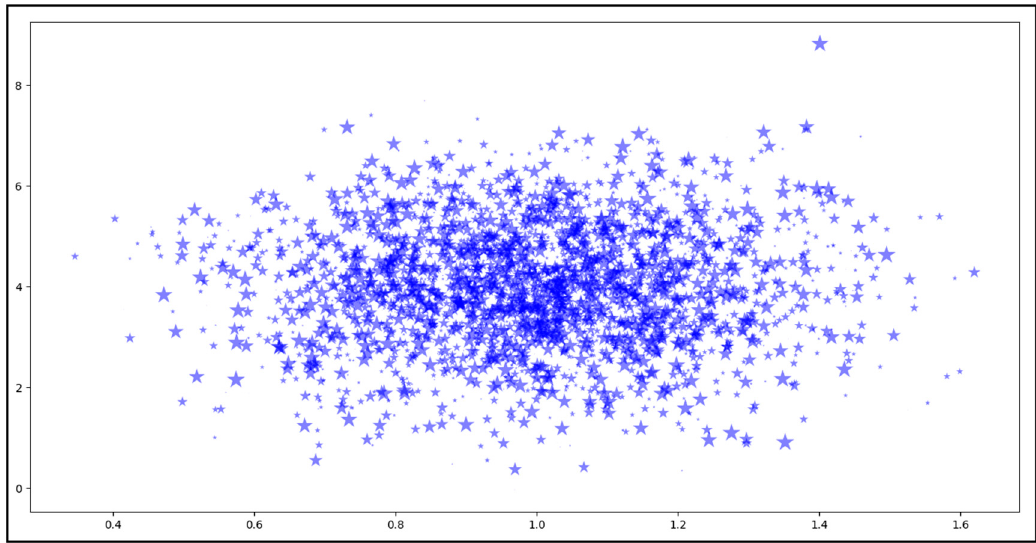
Figure 6. Subclustering classification (Diagnosis cluster).